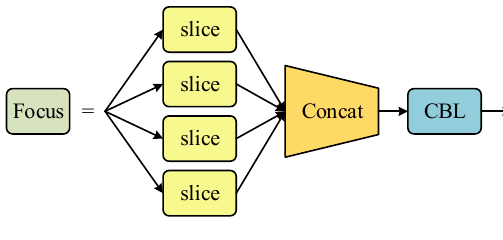
Figure 3. Focus structure.